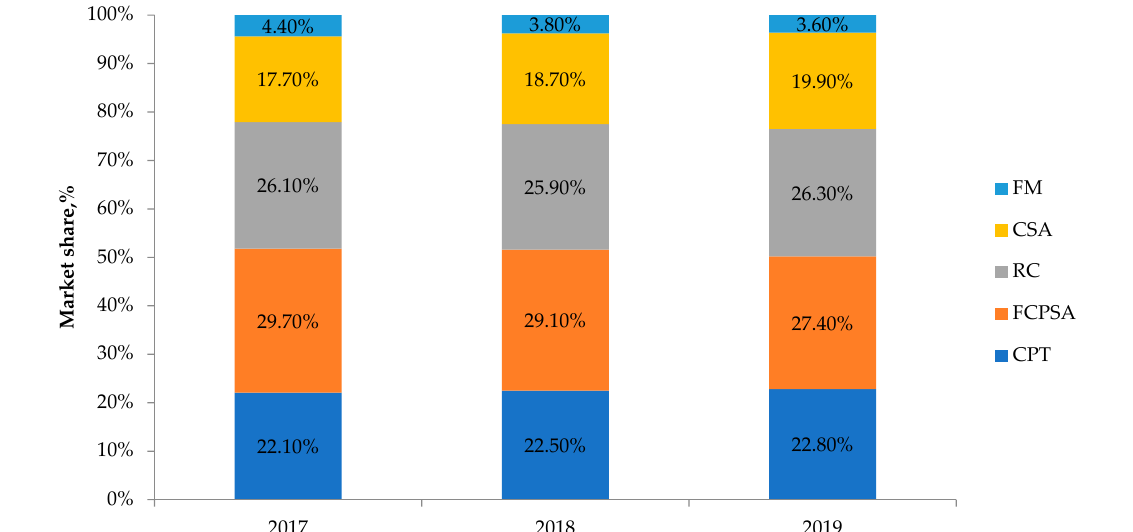
Figure 7. Volume structure of capacity trading in Russia: the first price zone. Source: own results based on [78].